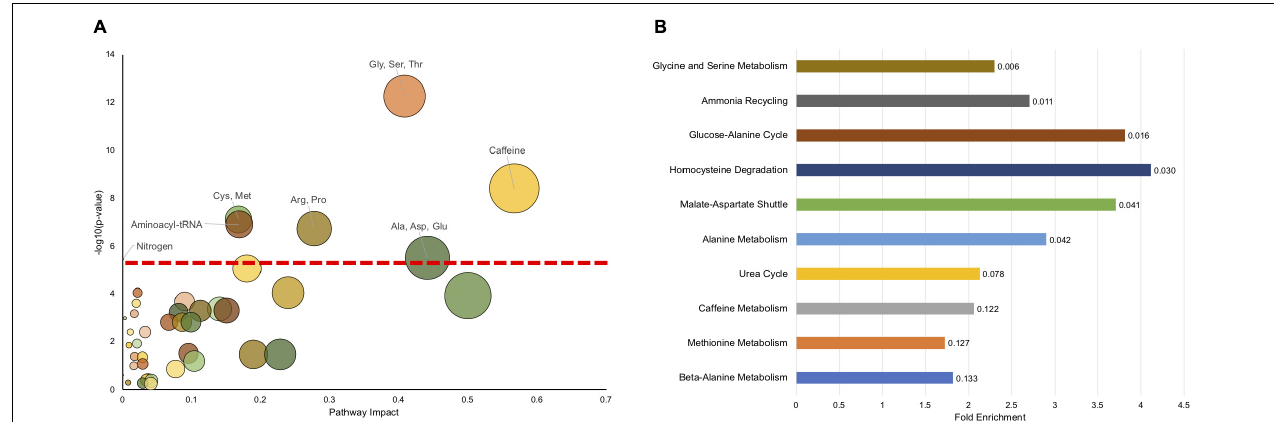
FIGURE 3 | Pathway enrichment shows significant enrichment in metabolic pathways related to amino acid metabolism. (A) The impact on a pathway (Pathway Impact) for a given KEGG pathway is shown on the x -axis, and the − log(p) of the uncorrected p -value is presented on the y -axis. The dashed horizontal red line represents the p < 0.05 cutoff after FDR correction. The pathways that are significant (FDR < 0.05) are labeled. (B) MSEA overrepresentation analysis displaying the top 10 enriched pathways. The length of the bar is the fold enrichment of the pathway with the scale presented at the bottom. The numbers indicated the raw p -value for